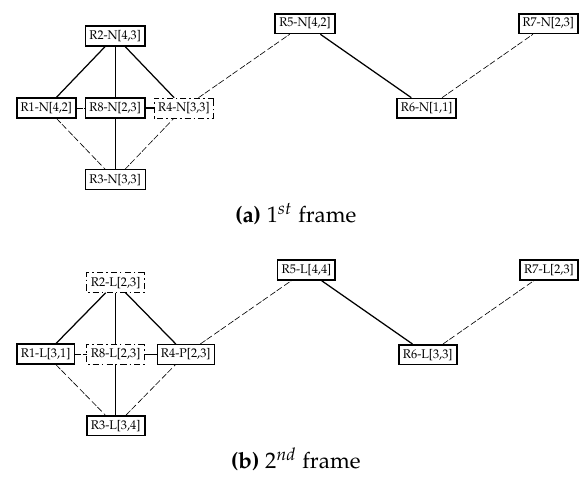
Figure 5. DEFAR scenario example.